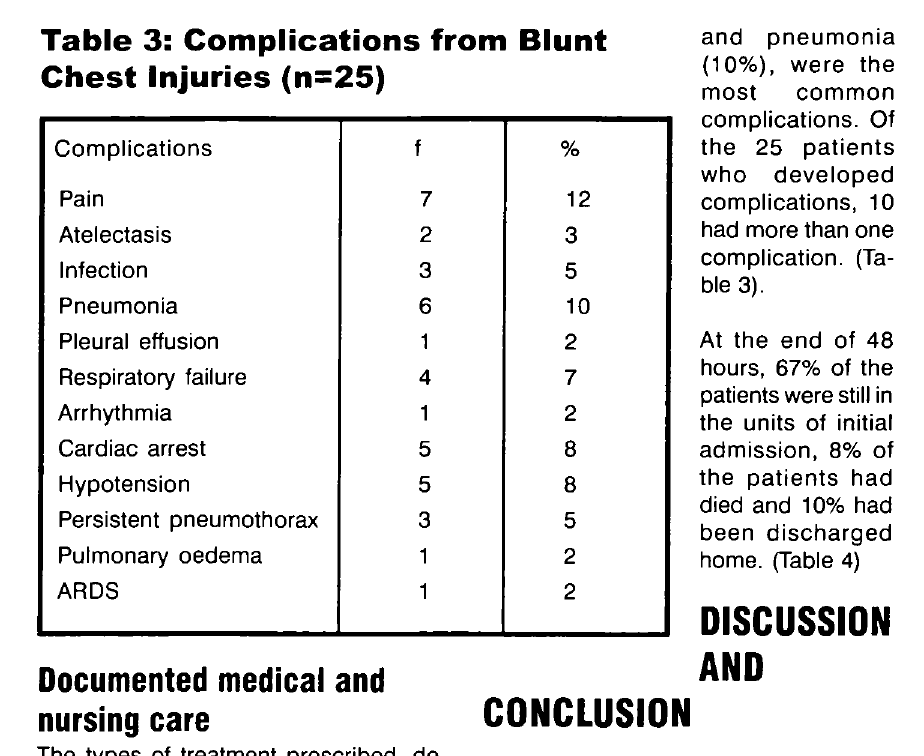
Table 3: Complications from Blunt Chest Injuries